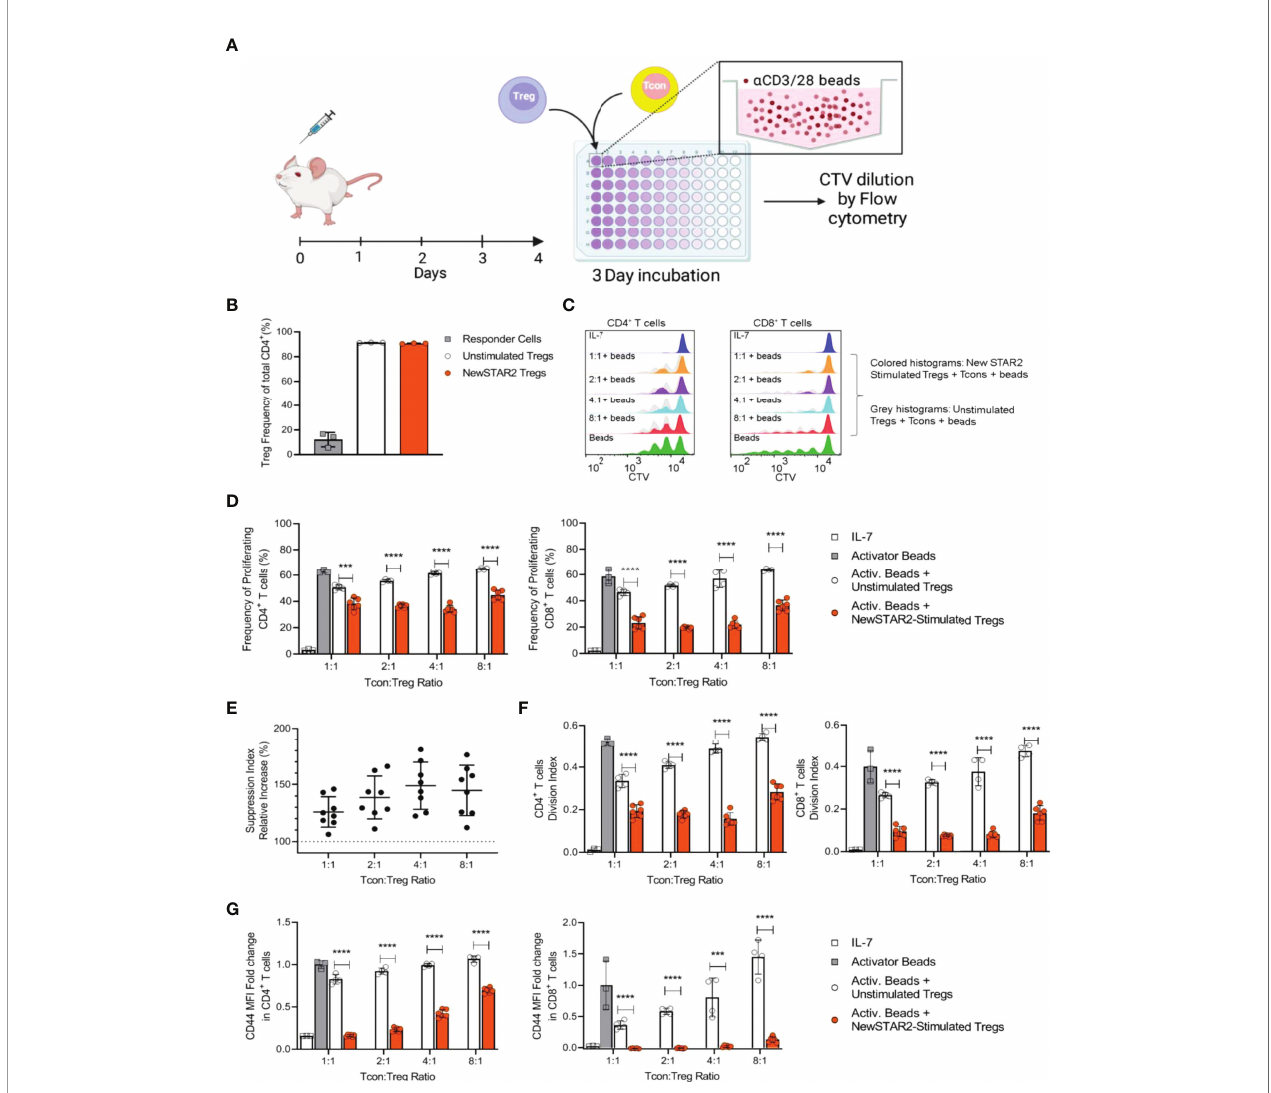
FIGURE 6 | NewSTAR2 increases the suppressive capacity of Tregs. (A) Experimental set-up of the in vitro Treg suppression assay. B6 wild type mice (CD90.2) were i.p. injected with 140 µg of NewSTAR2 or control Irrelevant IgG1 in PBS and spleens were dissected on day 4 after stimulation. Tregs were enriched through magnetic separation. In parallel, total T cells were isolated from spleens from untreated congenic B6.CD90.1 mice and labeled with CTV dye to measure Tcon proliferation (In repeated experiments CD90.1 Treg donor mice and CD90.2 total T cell donor mice were used). 5x10 4 Tcons were plated in each well with equal numbers of Tregs or fewer in order to achieve Tcon : Treg ratios of 1:1, 2:1, 4:1 and 8:1. Cells were cultured in cRPMI with suboptimal concentrations of CD3/28 activator beads for 4 days until fl ow cytometric analysis. (B) Representative data of relative Treg purities after cell enrichment. For each set of assays, samples were pooled from 3 mice within each group, and each data point represents one replicate. (C) Representative histograms of the responder CD4 + (left) and CD8 + T cells (right) 4 days after culture. Dark blue histograms: undivided cells cultured with IL-7; green: responder cells cultured with CD3/28 activator beads only. Orange, magenta, light blue and pink histograms show the generations of divided responder T cells by dilution of the CTV dye when cultured with Tregs from NewSTAR2- stimulated mice at the indicated Tcon : Treg ratios. Overlaid gray histograms represent the generations of divided responder T cells by dilution of the CTV dye when cultured with unstimulated Tregs at the indicated Tcon : Treg ratios. (D) Frequencies of proliferating CD4 + (left) and CD8 + responder T cells (right). Each data point represents the averaged values for one set of experiments in which cells of 3 mice were pooled for NewSTAR2-stimulated or unstimulated groups. C and D show representative data from 4 different experiments. (E) Increase in responder T cell suppression as the quotient of the frequency of proliferating cells in presence of unstimulated Tregs over the frequency of proliferating cells in presence of NewSTAR2-stimulated Tregs. Data from CD4 + and CD8 + T cells are shown together for each given ratio. (F) Average number of cell divisions that responder T cells of the original population have undergone (= division index) for CD4 + (left) and CD8 + (right) responder T cells. Representative data from 4 different experiments are shown. (G) Fold change of CD44 mean fl uorescence expression levels of CD4 + T cells normalized to the MFI values of responder cells cultured only with CD23/28 activator beads. (D – G) One data point corresponds to the averaged values from each treatment of one suppression assay. Data are presented as means +/- SD, ***p ≤ 0.001, ****p ≤ 0.0001, two-tailed unpaired Student ’ s t